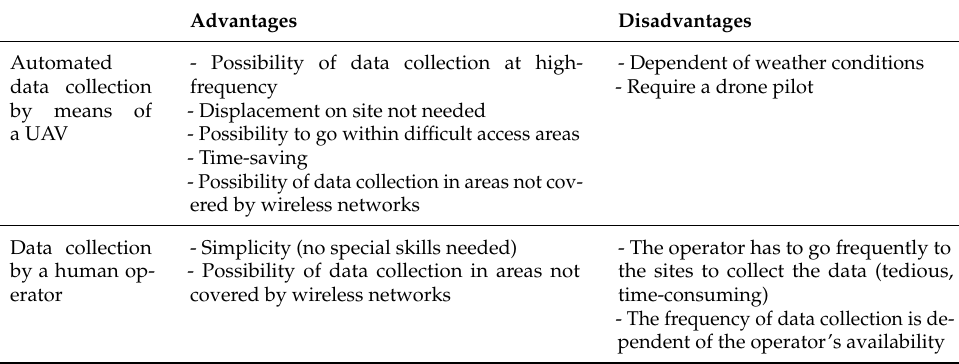
Table 6. Advantages and disadvantages of the automated solution compared to the manual